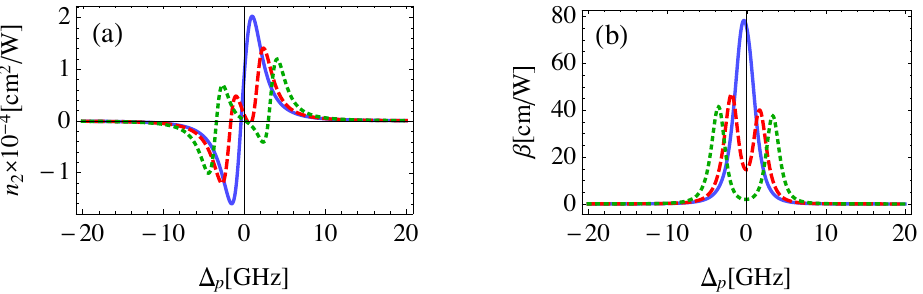
Figure 4. The self-Kerr nonlinear index of refraction ( a ) and nonlinear absorption coefficient ( b ) in the MNP-GND-QD hybrid system of R QG = 12 nm, θ G = 1 rad, θ M = 0.5 rad excited with resonant control field of Ω c = 1 GHz. (solid), Ω c = 5 GHz (dashed) and Ω c = 10 GHz